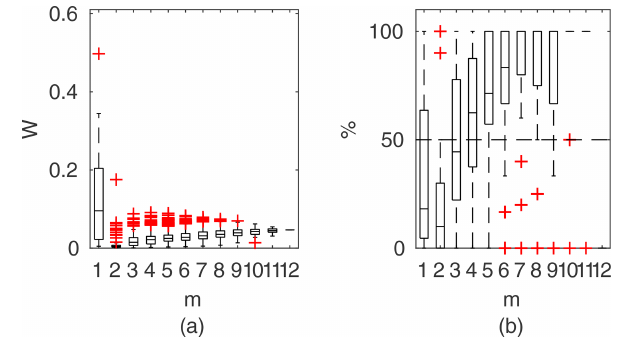
Figure B13. STLM results for the Ritobacken case study, spring 2011: (a) averaged relative confidence widths W as a func- tion of observation set size m used for model identification; (b) per- centage of verification points enclosed by the confidence inter- vals (100% denotes all points within intervals, box spans over the 25% and 75% quantiles, the median is given with horizontal line, whiskers indicate the result extent, and cross marks are for extreme values).